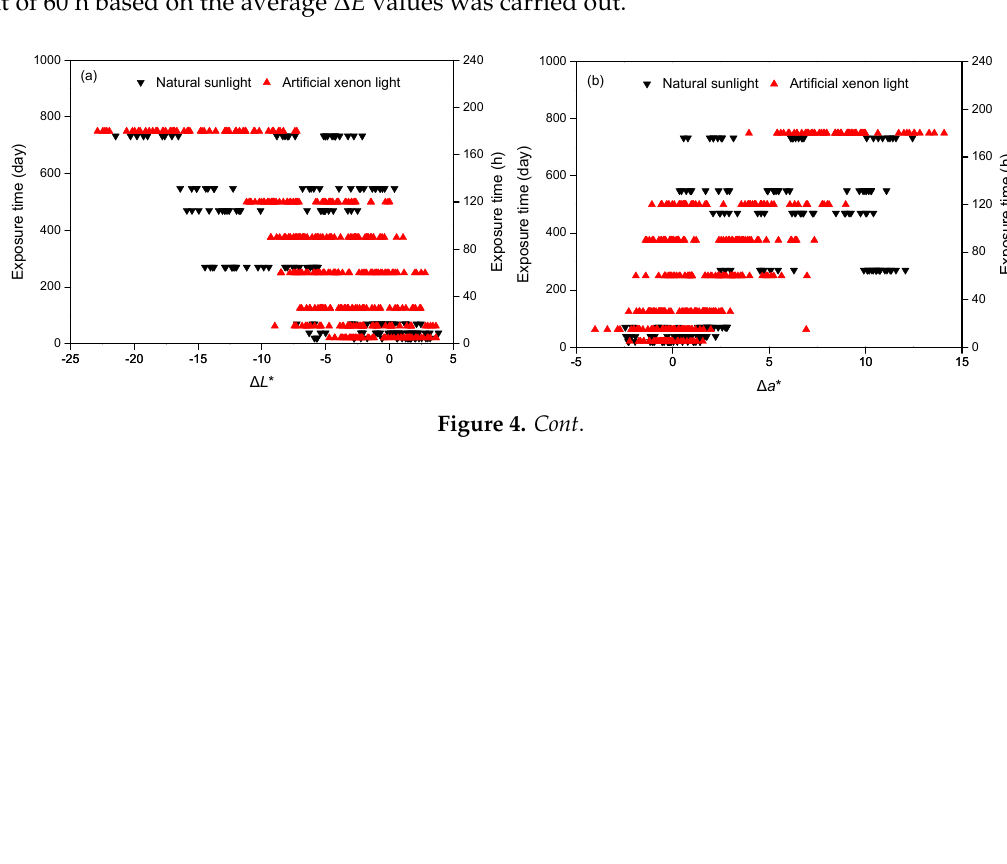
Figure 3. Color changes of woods during artificial xenon light weathering. (a) Δ L *; (b) Δ a *; (c) Δ b *; (d) Δ E.